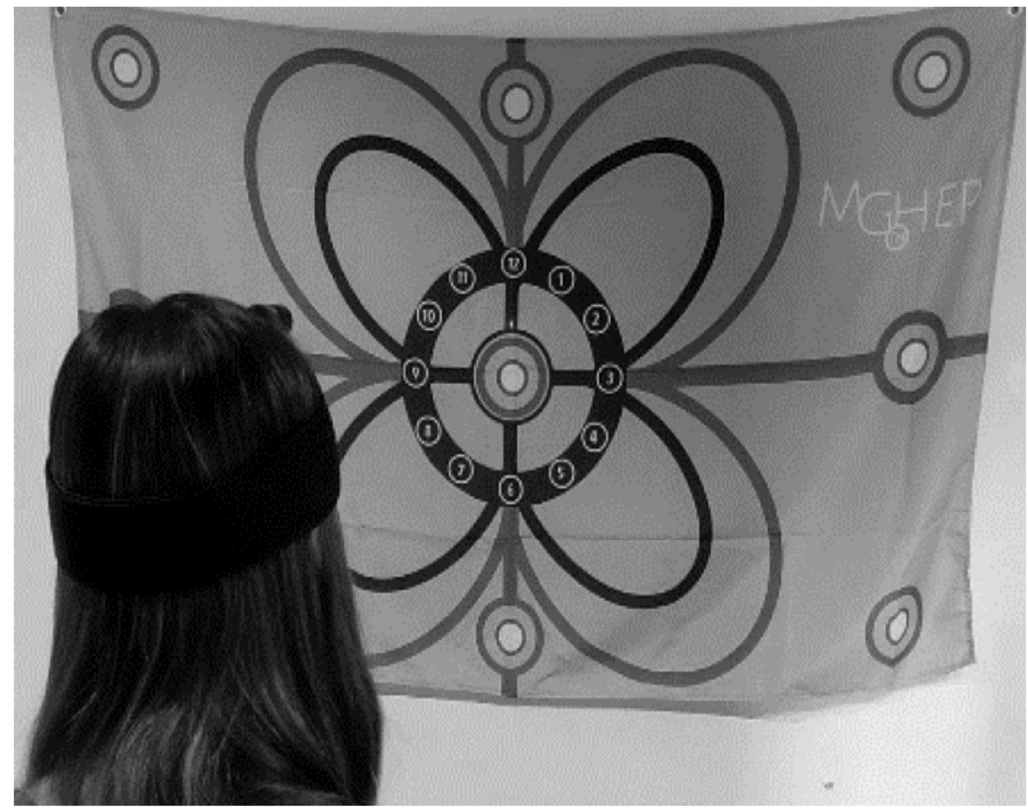
Figure 3. Specific Therapeutic Exercise intervention. Exercises with visual feedback with a laser sensor (Motion Guidance).